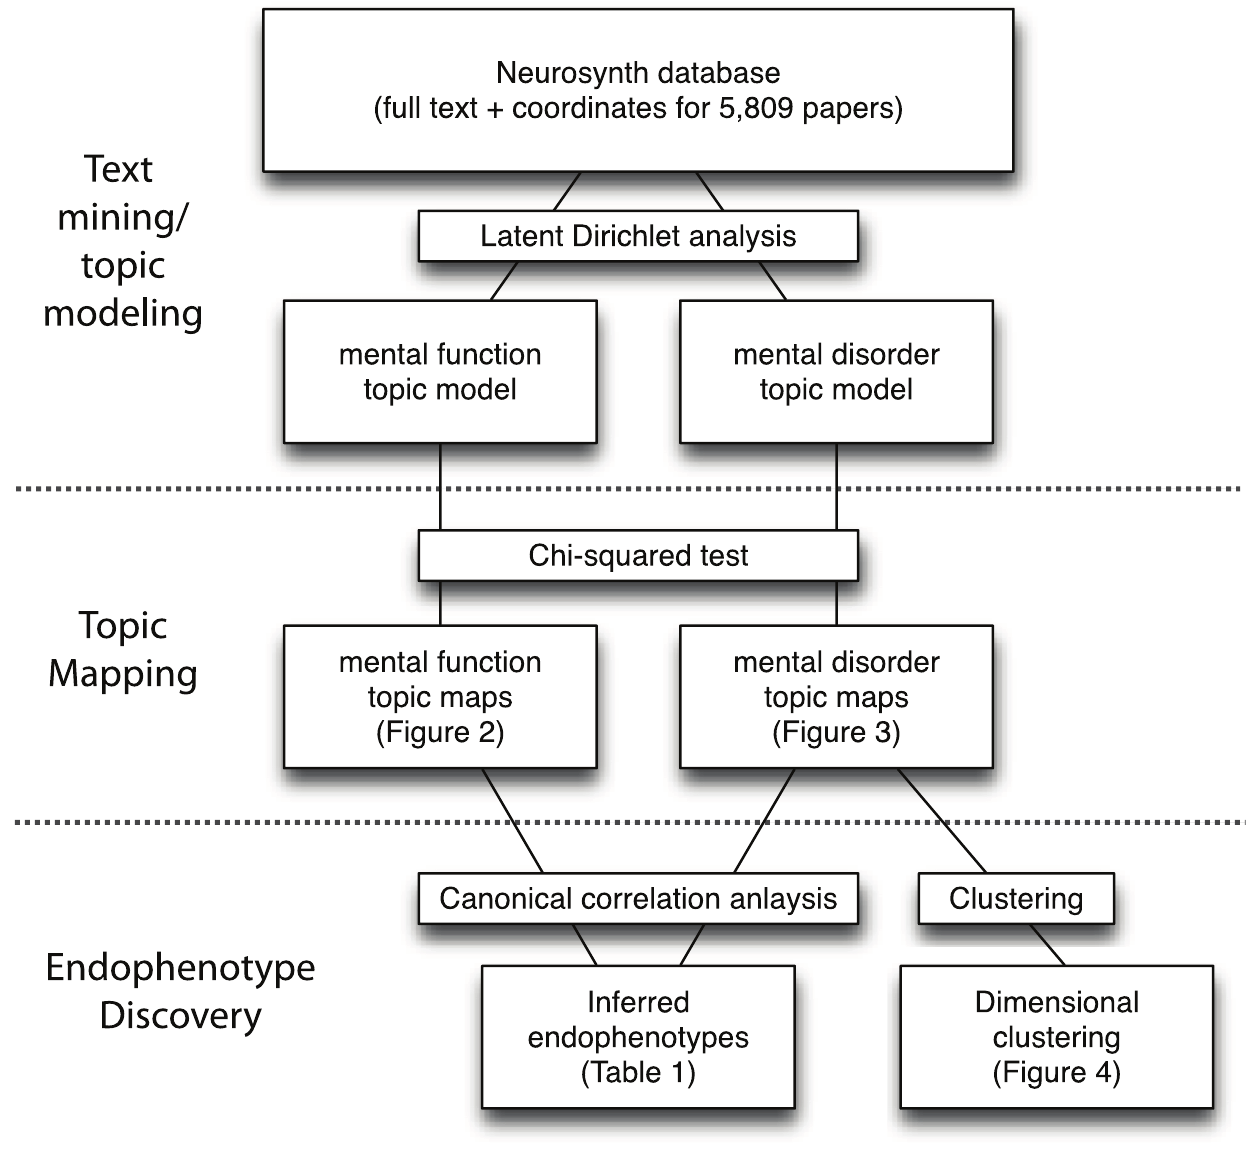
Figure 1. A schematic overview of the data processing pipeline used in the analyses presented here.